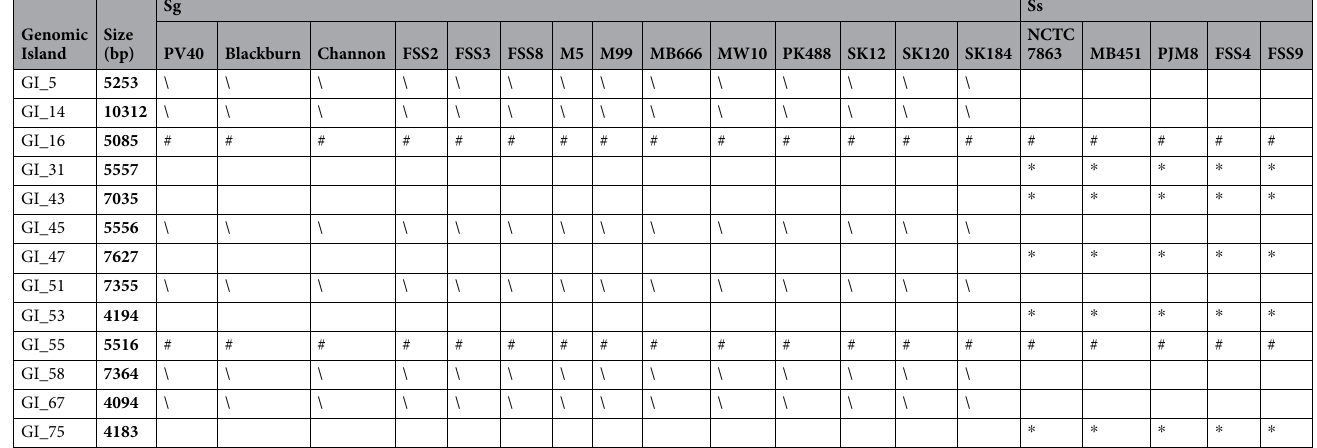
Table 2. Summary of predicted GIs in the genomes of Sg and Ss. Two conserved GIs were shared by Ss and Sg (marked with hashtag), six Sg - specific GIs (marked with backslash) and five Ss-specific GIs (marked with